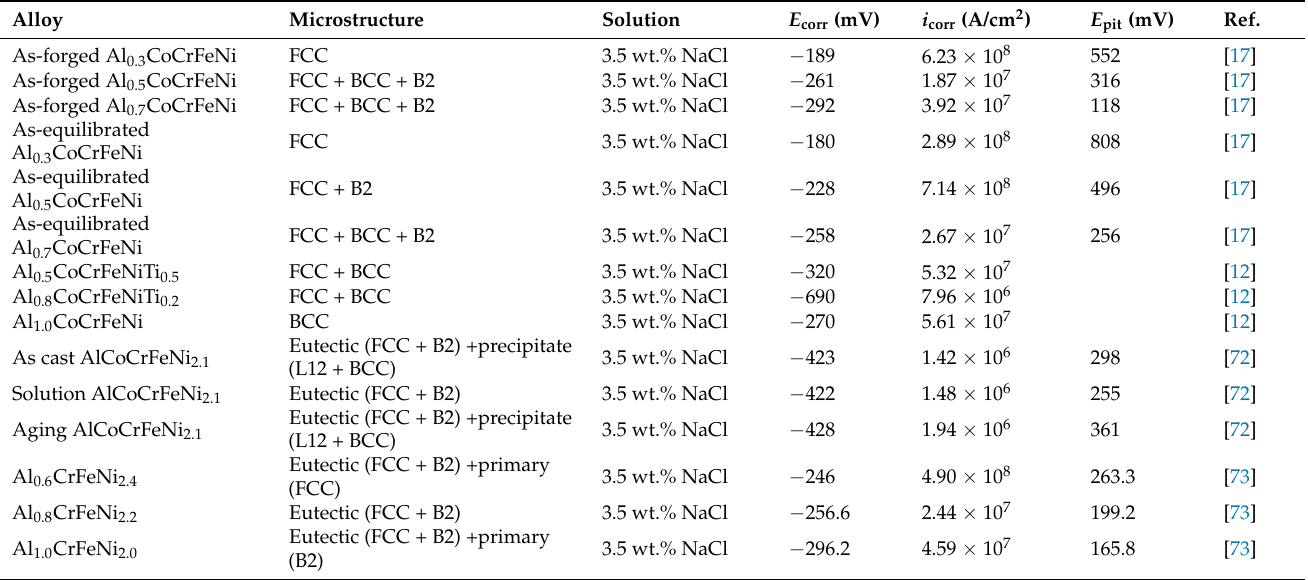
Figure 8. The microstructure, polarization behaviors, and corrosion failure morphologies of dual- phase Al x CoCrFeNi ( x = 0.3, 0.5, and 0.7) HEAs. ( a ) The elemental distribution by EDS mappings in Al x CoCrFeNi, in which the brown colour represents Al, the violet colour represents Ni, the yellow colour represents Ni, the blue colour represents Cr, and the green colour represents Fe; ( b ) potentiodynamic polarization curves in the 3.5 wt.% NaCl aqueous solution, in which the black curve is Al 0.3 CoCrFeNi, the red curve is Al 0.5 CoCrFeNi, the green curve is Al 0.7 CoCrFeNi; and SEM micrographs after potentiodynamic polarization for the Al 0.3 CoCrFeNi ( c 1 ), Al 0.5 CoCrFeNi ( c 2 ) and Al 0.7 CoCrFeNi ( c 3 ), the white arrows represent the corrosion pits and selective corrosion of BCC phase. [44]. Table 1. Electrochemical parameters of HEAs with various microstructure in the chloride-containing solution at room